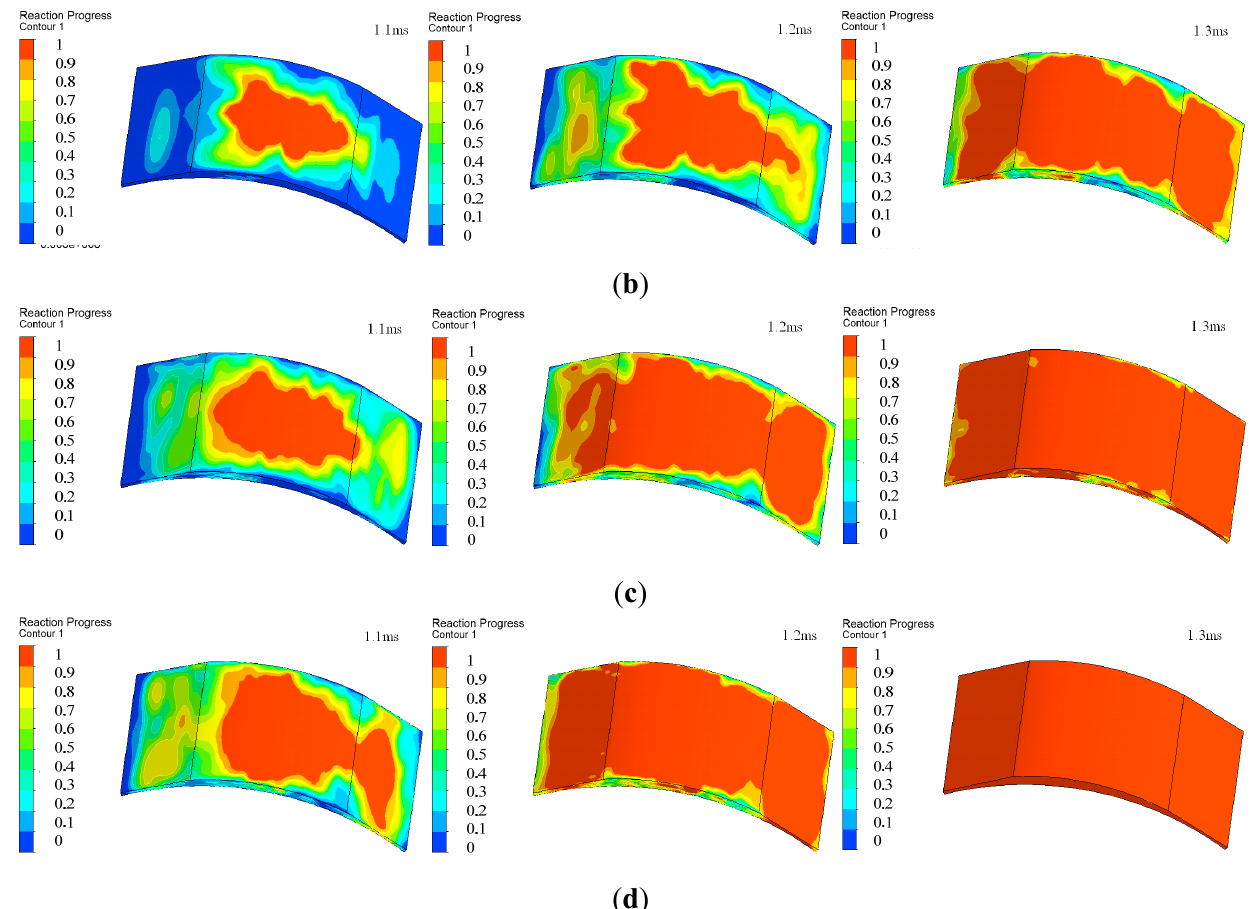
Figure 9. ( a ) Reaction process at excess air ratio 1.1; ( b ) Reaction process at excess air ratio 1.0; ( c ) Reaction process at excess air ratio 0.9; ( d ) Reaction process at excess air ratio